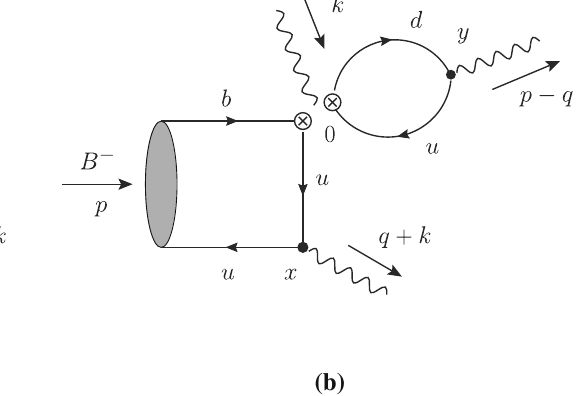
Fig. 1 FeynmandiagramsofthecorrelationfunctiongiveninEq.(27). a is the W -exchange diagram, and b is the W -emission diagram. The gray bubble denotes the B meson, the pairs of crossed circles represent